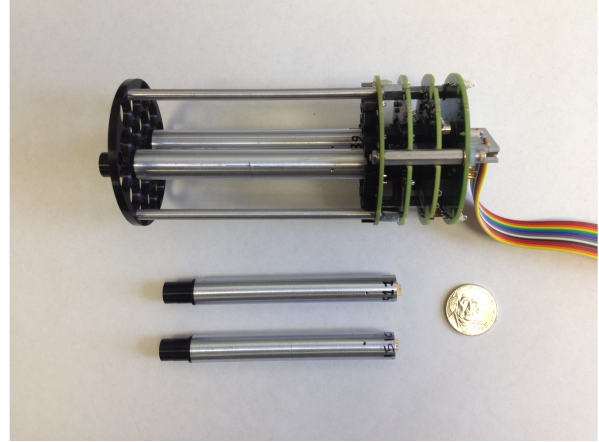
Figure 15. SPRITE, a prototype instrument for the investiga- tion of the polarimetric cloud thermodynamic phase determination technique. Microradiometers manufactured by Biospherical Instru- ments, Inc. (below) will be used with a modular housing (above) that allows for up to 19 individual